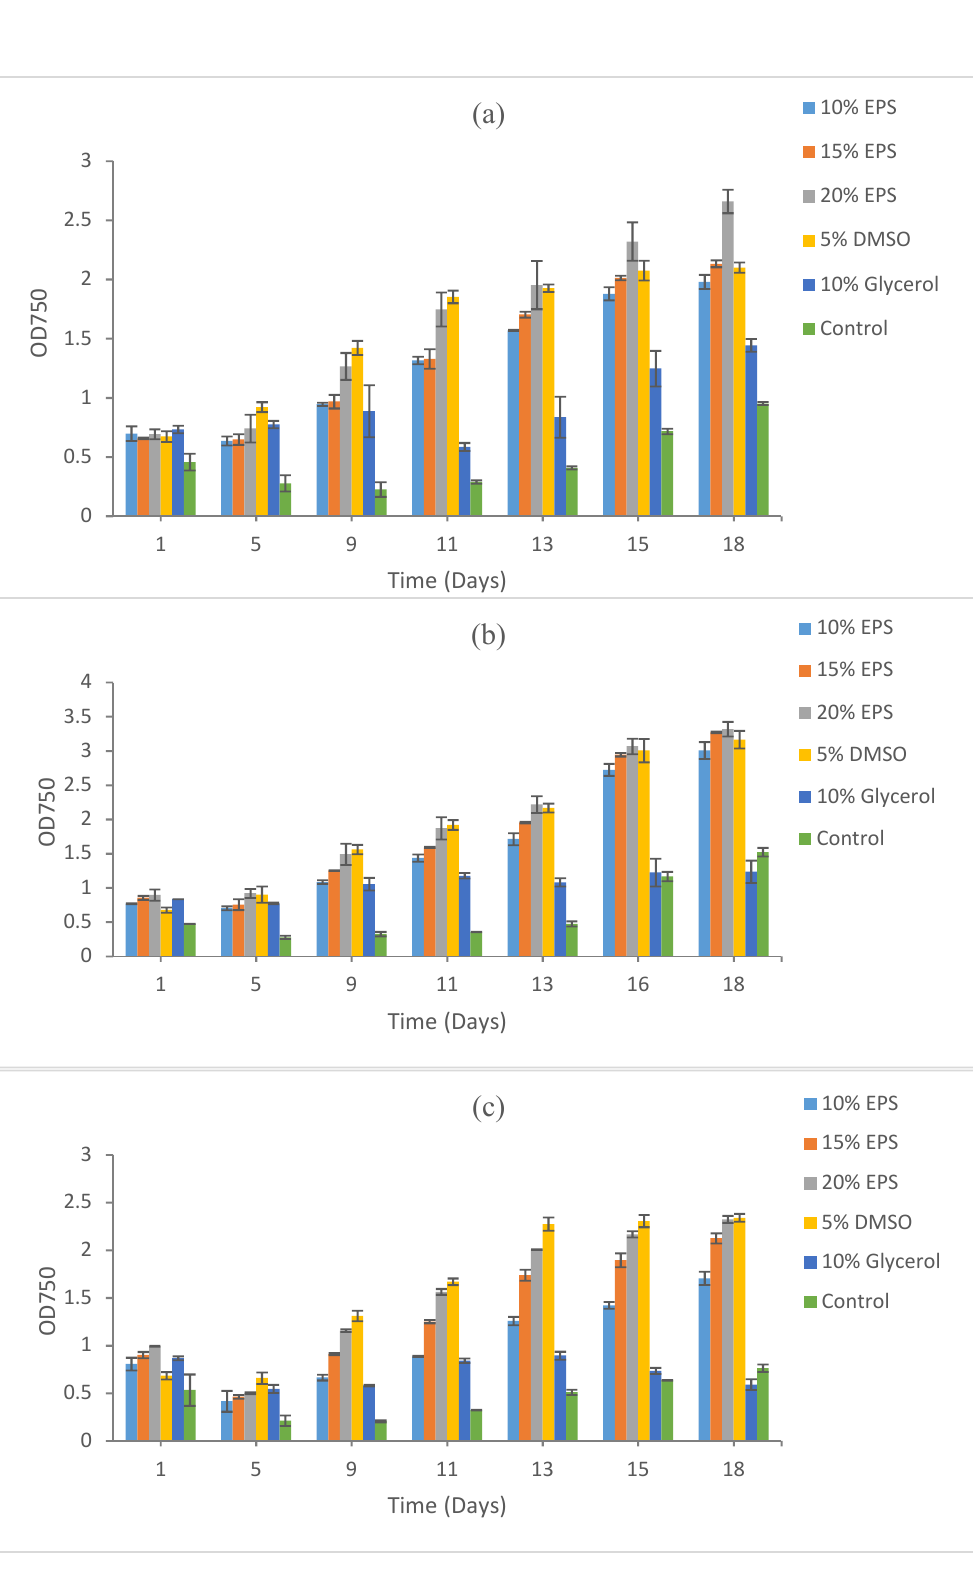
Figure 1. Growth recovery for Synechococcus sp. CBW1003 after cryopreservation for ( a ) 5 days, ( b ) 15 days, and ( c ) 9 months. Duplicate samples were measured. The images of cultures at the end points refer to Figure S3. DMSO: dimethyl sulfoxide; EPS: exopolysaccharide.